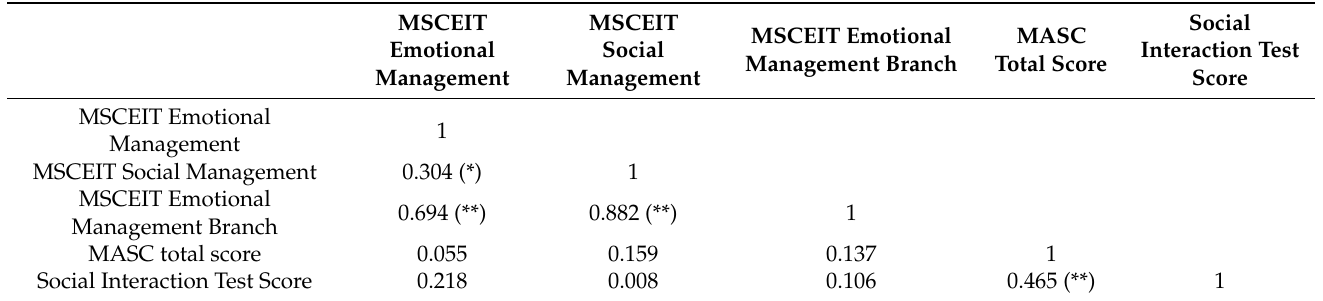
Table 3. Pearson Correlation matrix of the social cognition assessment